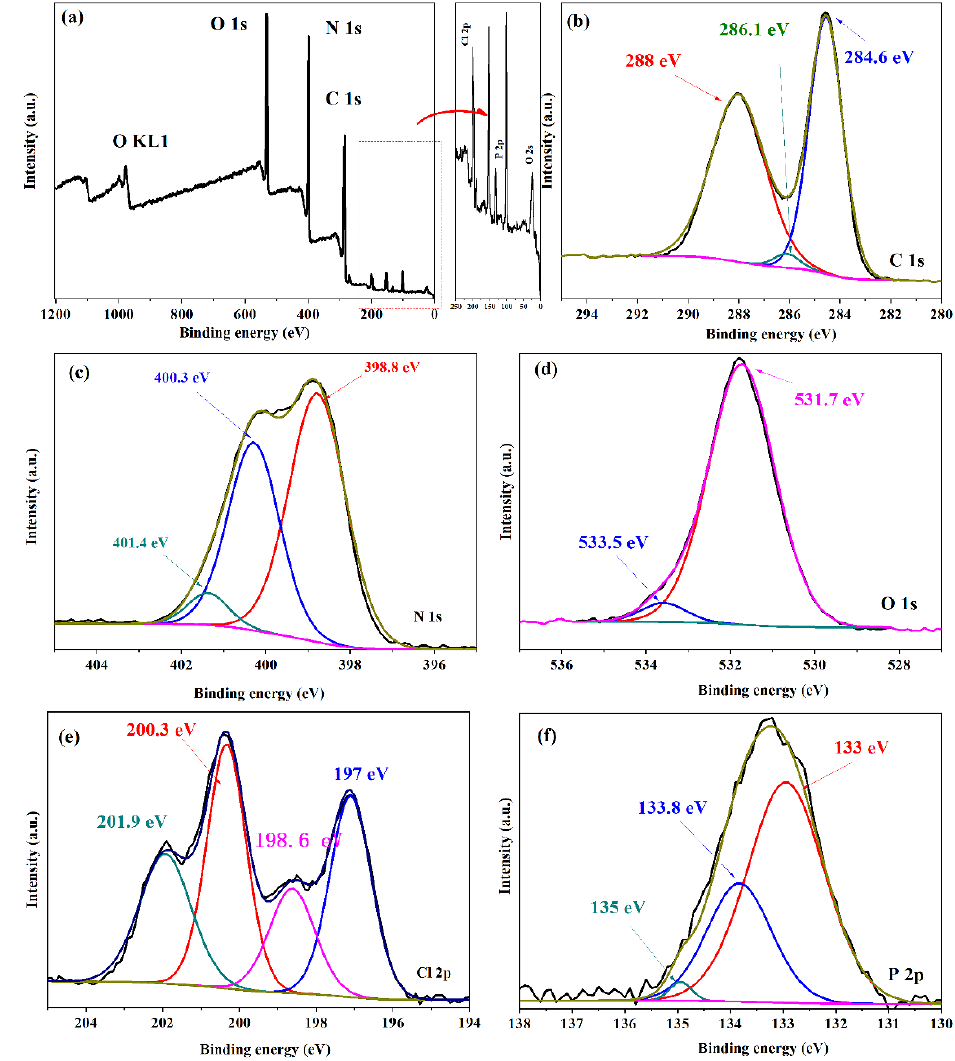
Figure 5. XPS spectra of 15% P-SSCN: ( a ) survey spectrum, ( b ) C 1s, ( c ) N 1s, ( d ) O 1s, ( e ) Cl 2p, and ( f ) P 2p.